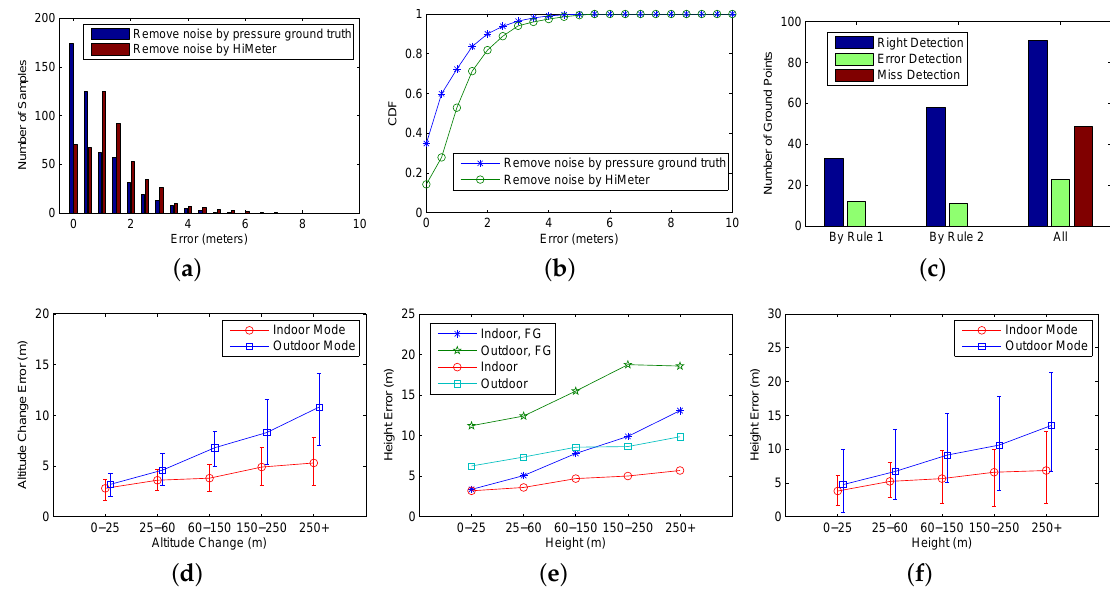
Figure 9. Evaluation results. ( a ) Accuracy of removing weather noise; ( b ) CDF of removing weather noise; ( c ) ground distinguishing accuracy; ( d ) altitude change measurement accuracy; ( e ) height accuracy in different situations (FG: false ground); ( f ) average height